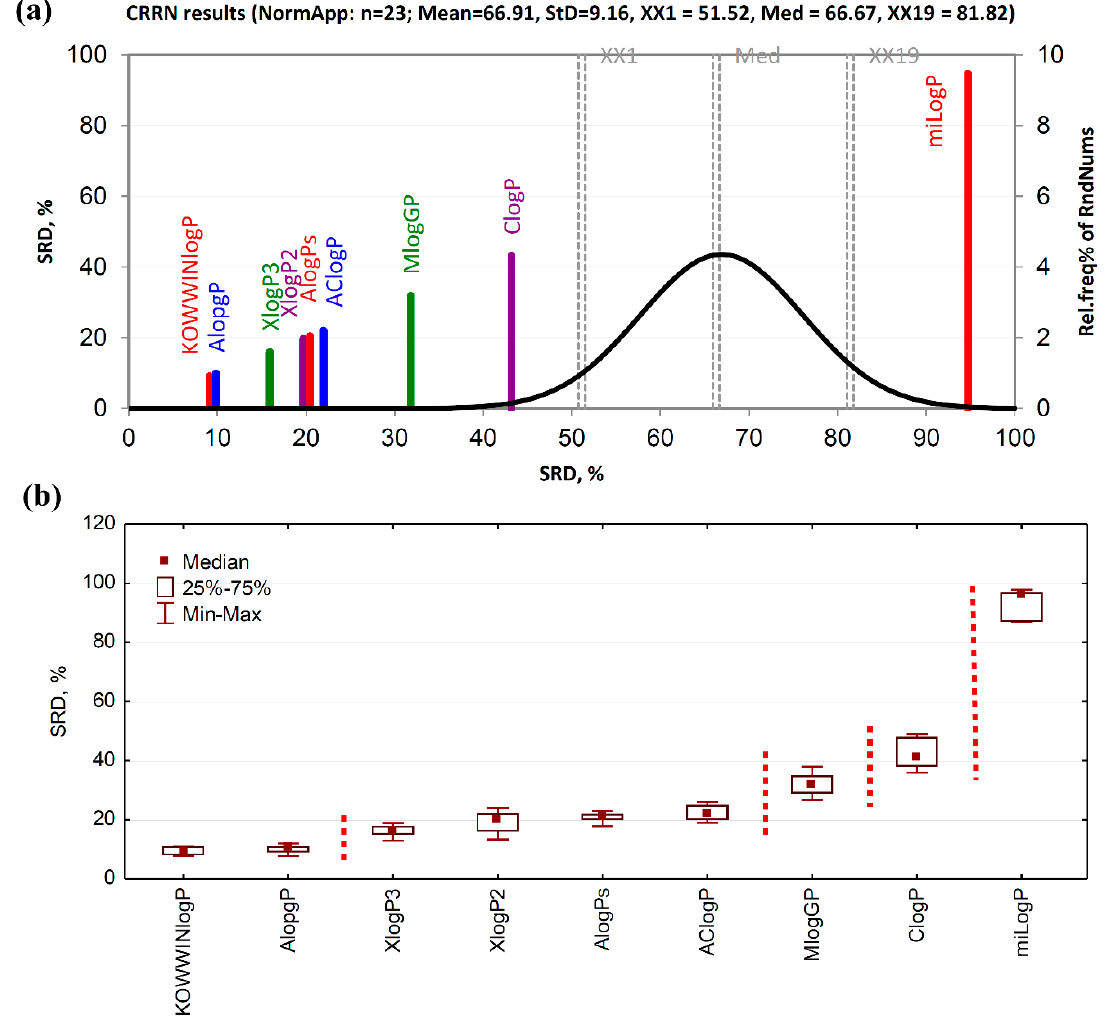
Figure 2. Ranking of computational methods for lipophilicity estimation. ( a ) sum of ranking differences-comparison of ranks by random numbers (SRD-CRRN) of standardized log P values; the SRD values are depicted on x and y axes, n = 23, random distribution Mean = 66.91, StD = 9.16, XX1 = 51.52, Med = 66.67, XX2 = 81.82. The smaller the SRD value, the better, i.e., closer to the consensus, the computational method is. ( b ) Box and whisker plot of normalized SRD values obtained by the sevenfold cross-validation. Statistically significantly different methods ( p = 0.05, tested by both the sign test and the Wilcoxon’s matched pairs test), are separated by dashed lines.